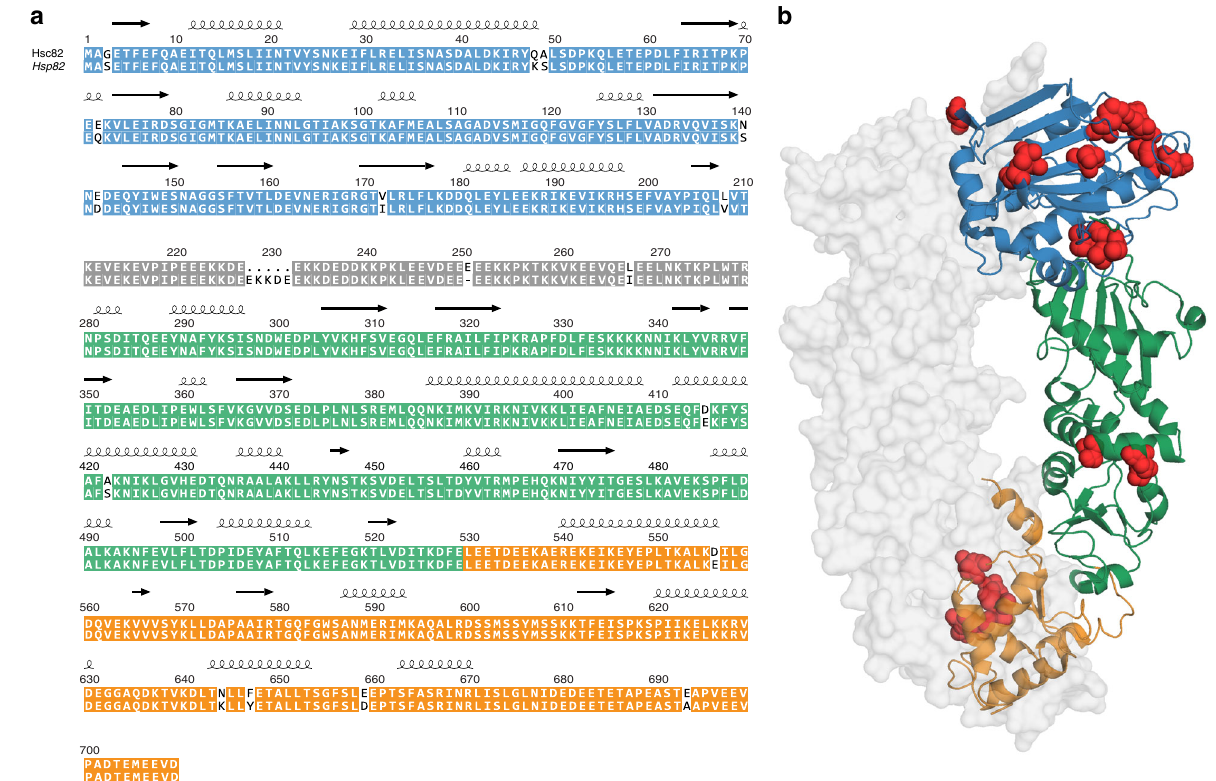
Fig. 1 Comparison of amino acid sequence and structure of the yeast Hsp90 isoforms. a Sequence alignment of Hsc82 and Hsp82. The NTD of the isoforms is depicted in blue, the charged linker in gray, the MD in green, and the CTD in orange. The differences in amino acid sequence are highlighted in red. b Hsp82 structure in the closed state (PDB ID: 2CG9 20 ). Sequence differences between Hsp82 and Hsc82 are highlighted in red